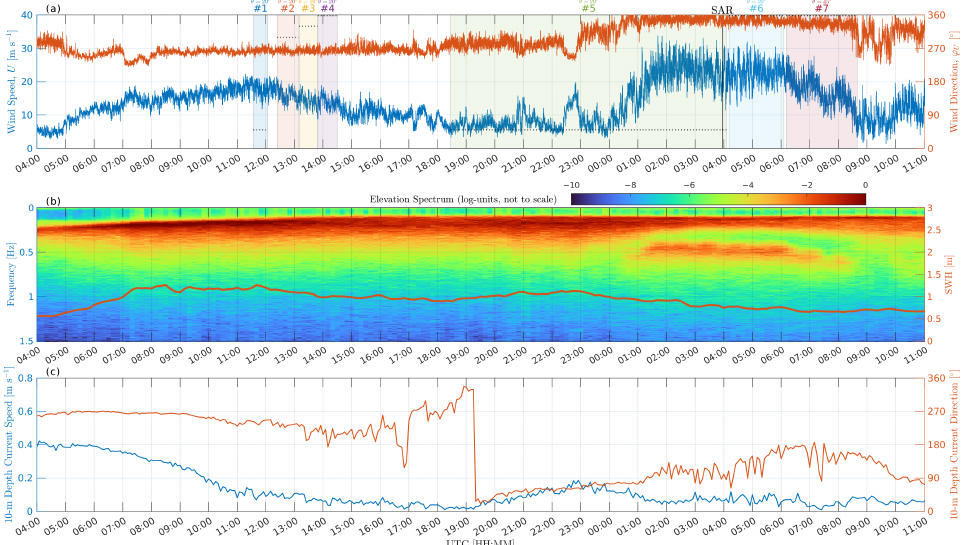
Figure 2. Environmental conditions during 24–25 October 2018. ( a ) Wind speed and wind direction with shaded rectangles indicating record spans. Radar azimuth for each record is shown by horizontal dashed lines. Vertical solid line indicates the acquisition time of the SAR image shown in Figure 1a. ( b ) Temporal evolution of wave elevation frequency spectrum. Significant wave height (SWH) is shown by red bold line against the right y-axis. ( c ) Current speed and direction at 10 m